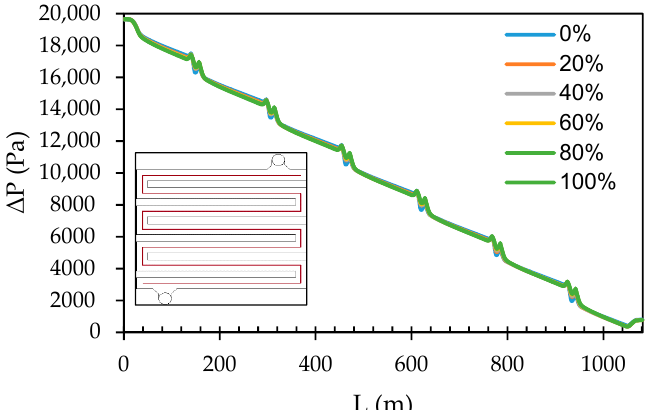
Figure 9. Development of TMP along the centerline in the flow path at different spacer curviness values.